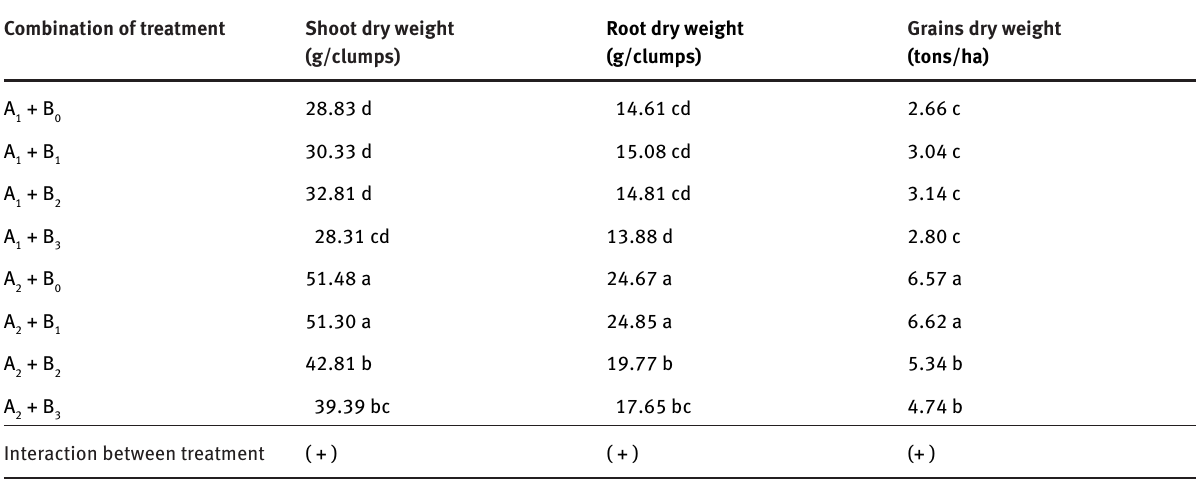
Table 2: The Effect of Treatment Interactions between Soil Water Content and Biochar Application on the Dry Weight of Shoots, Roots, and Grains